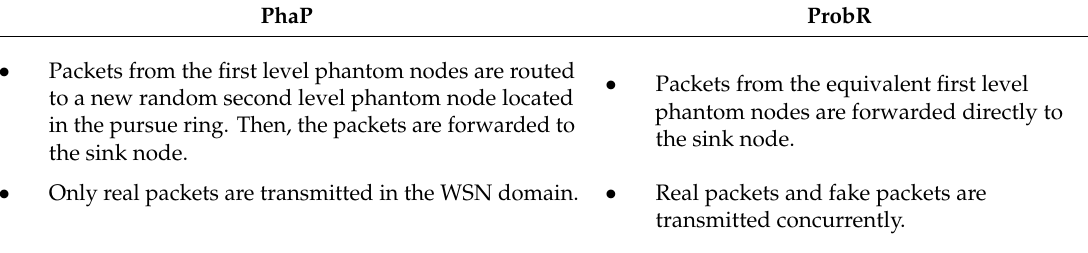
Table 2. Key di ff erences between the routing strategies of the proposed and existing